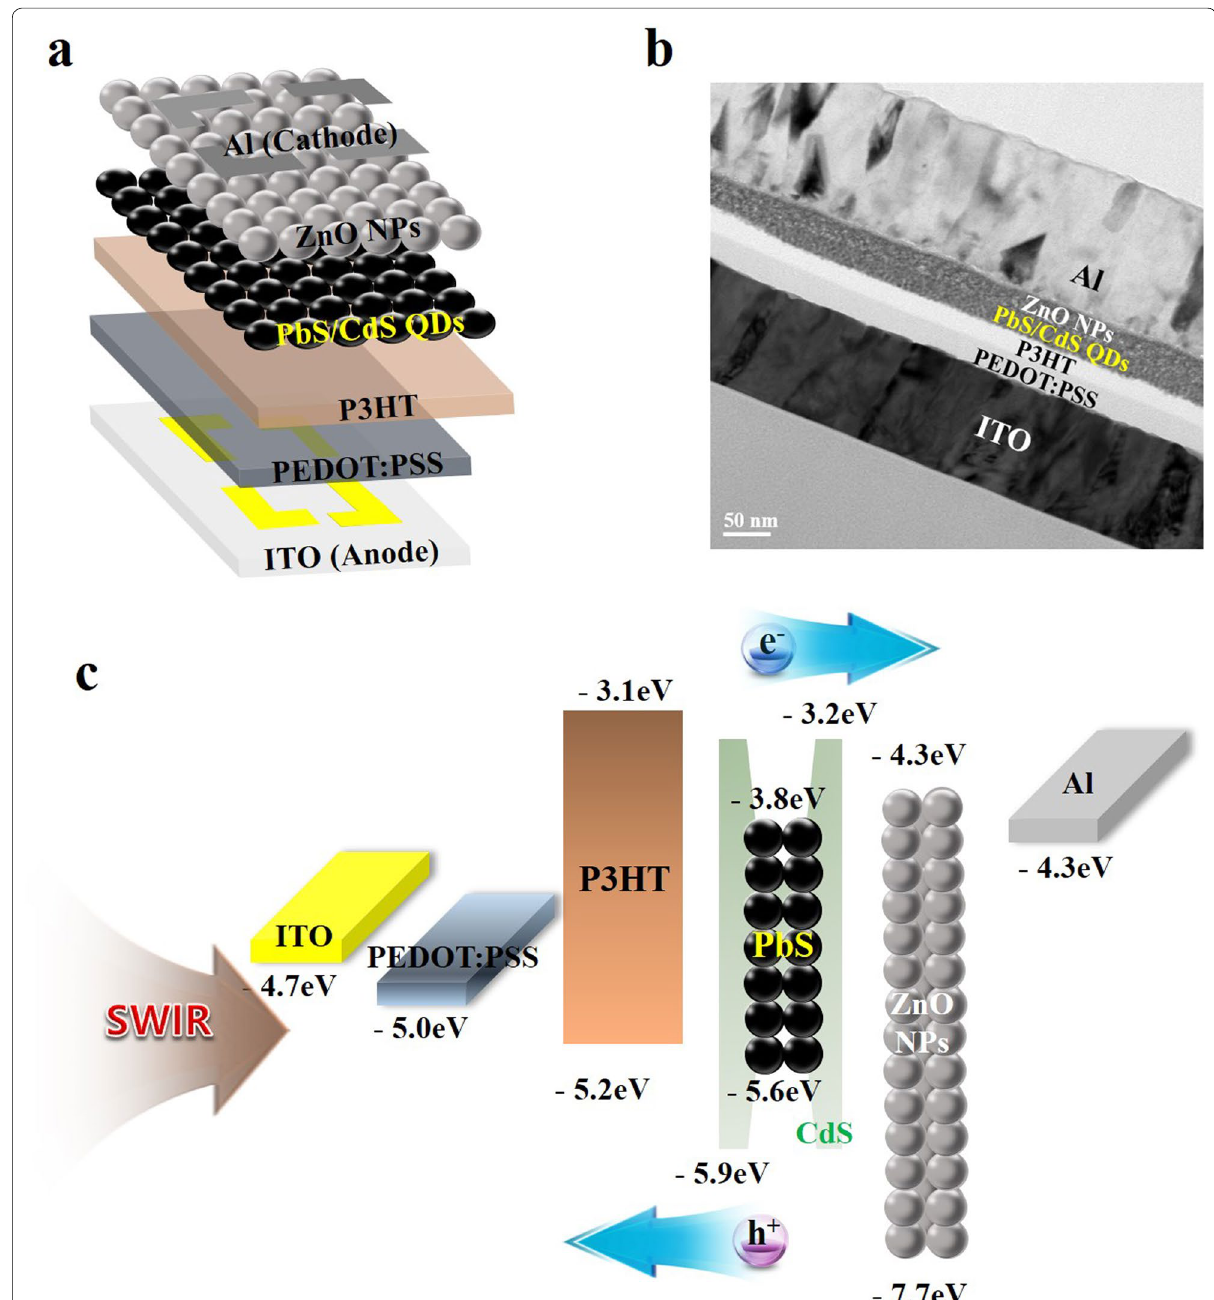
Fig. 4 Device structure and TEM images of the all solution‑processed SWIR photodetectors. a Schematic device structure, b cross‑sectional (scale bar, 50 nm), and c energy band diagram of the all solution‑processed SWIR